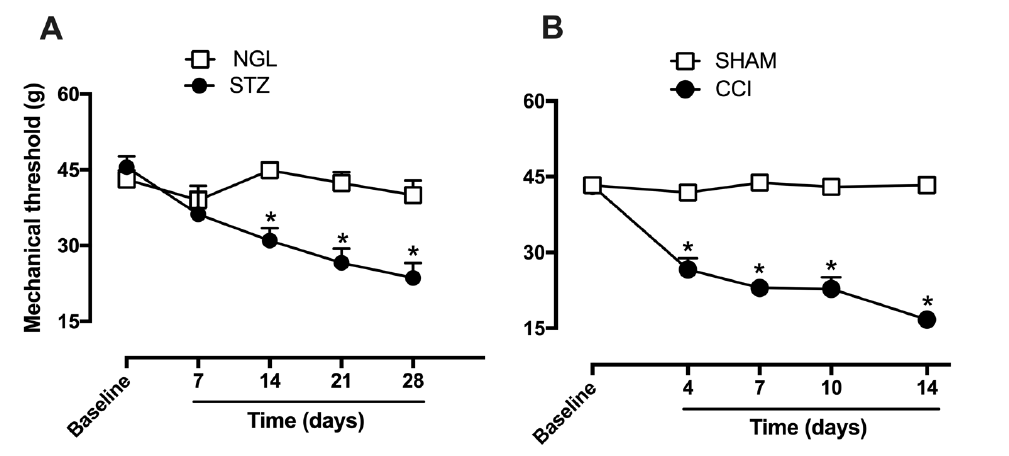
FIGURE 1 - Evaluation of mechanical allodynia, using electronic von Frey test, in different time points after (A) diabetes confirmation (STZ) and (B) chronic constriction of the sciatic nerve (CCI). Values represent mean ± SEM and * indicates p<0.05 when in comparison to their respective control groups (NGL or SHAM). Repeated-measures two-way ANOVA followed by Bonferroni’s post hoc